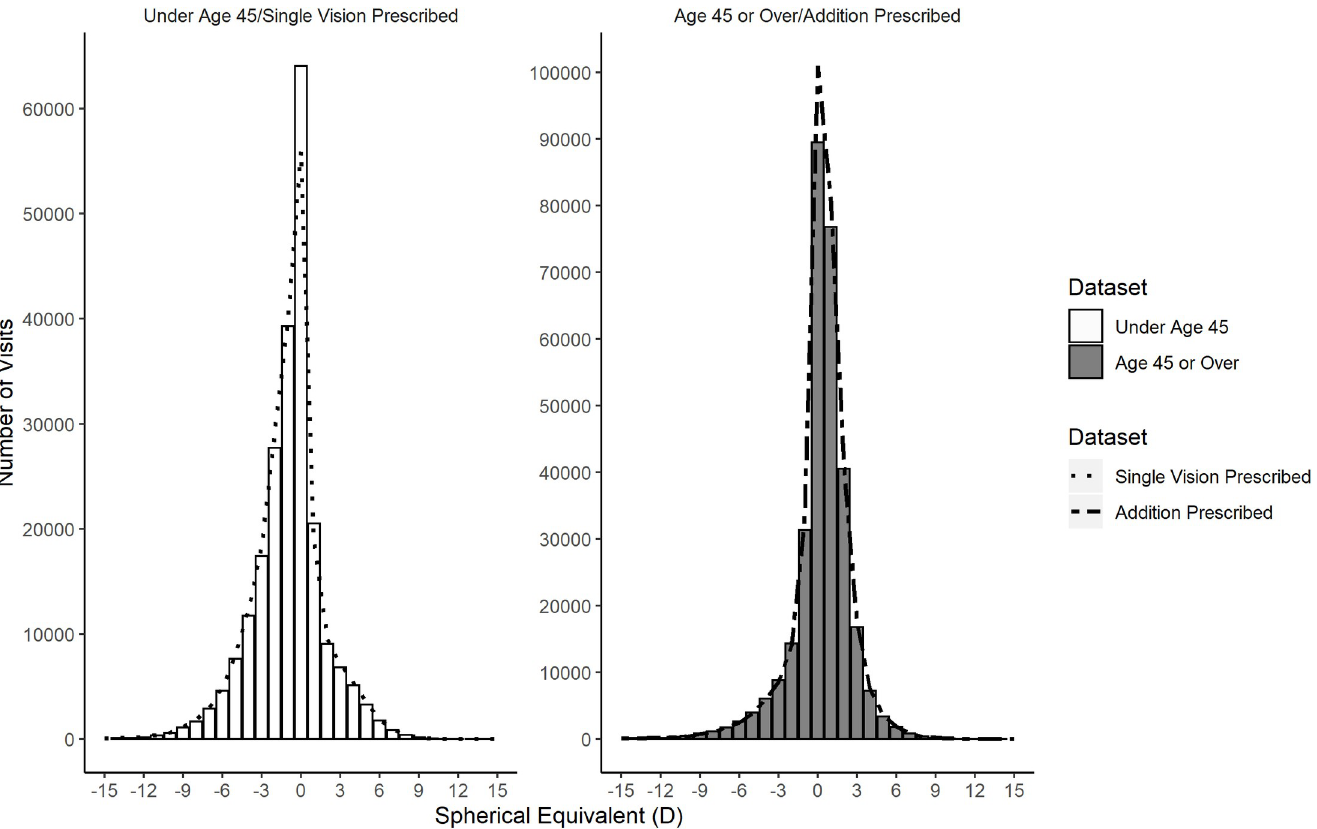
Fig 3. Age and the prescribing of an addition are highly correlated in EMR patients. Distribution of spherical equivalent for those under age 45 (left panel bars) and those age 45 and over (right panel bars). The dotted line represents the distribution of spherical equivalent for those given a single vision prescription (left panel) and those given a prescription containing an addition (right panel).